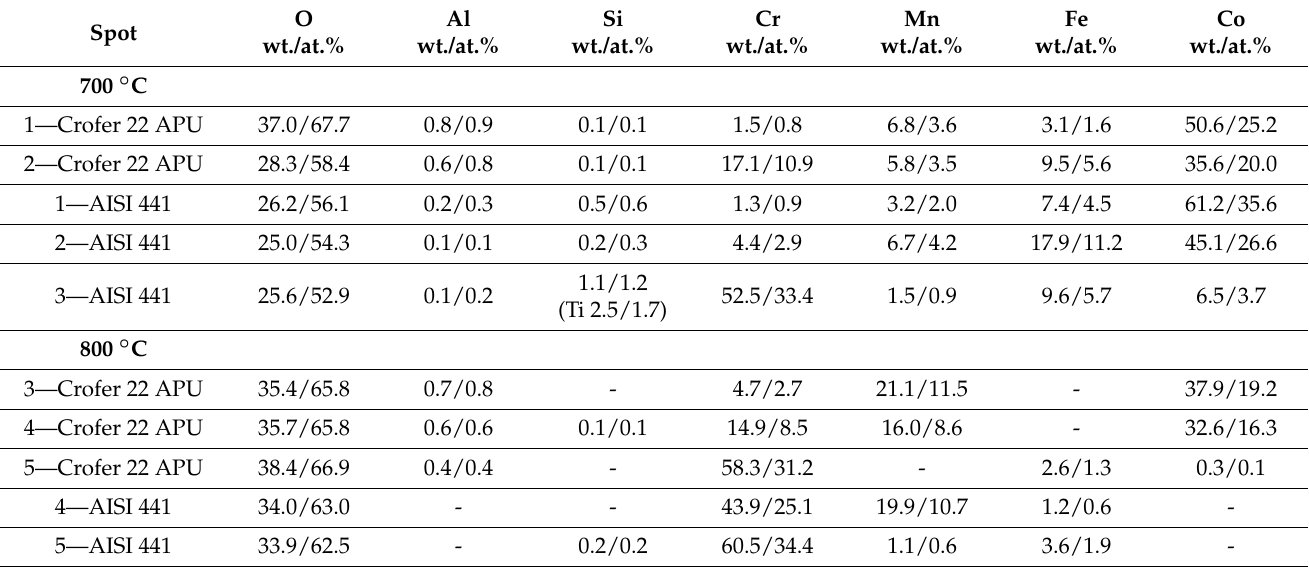
Table 5. Element concentrations in wt./at.% measured with EDS analysis from Ce/Co coated Crofer 22 APU and AISI 441 after 1500 h at 700 and 800 ◦ C. The locations of the spots are marked in Figure 9. The presence of Al likely originates from the polishing